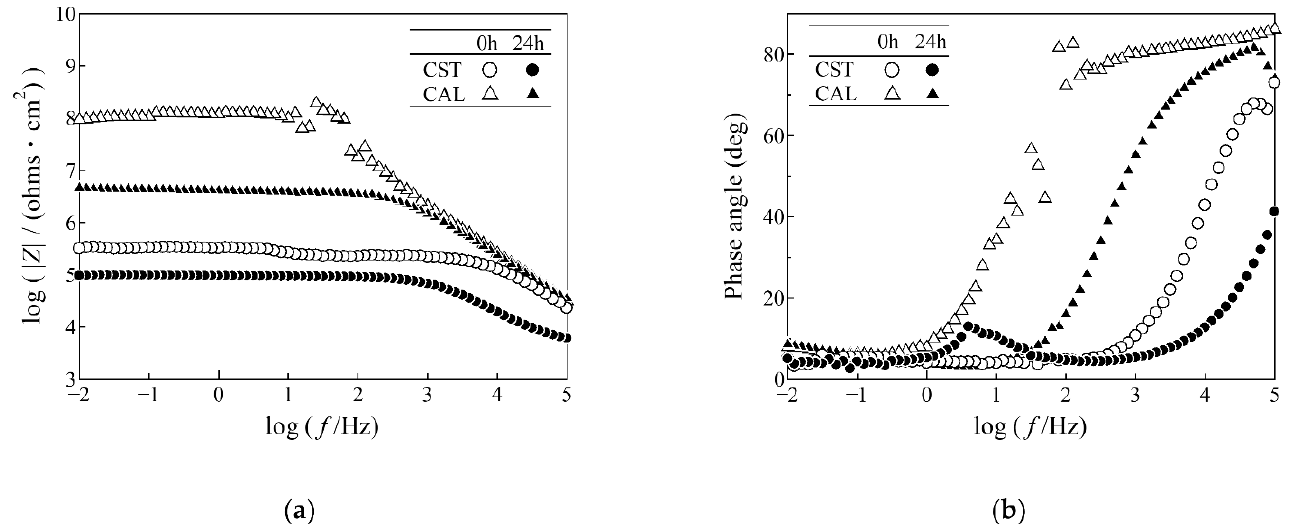
Figure 20. EIS measurements of blasted specimens after immersing in 3.5 wt% NaCl solution for 24 h showed by Bode plots: ( a ) log |Z|-log f , ( b ) Phase angle-log f.